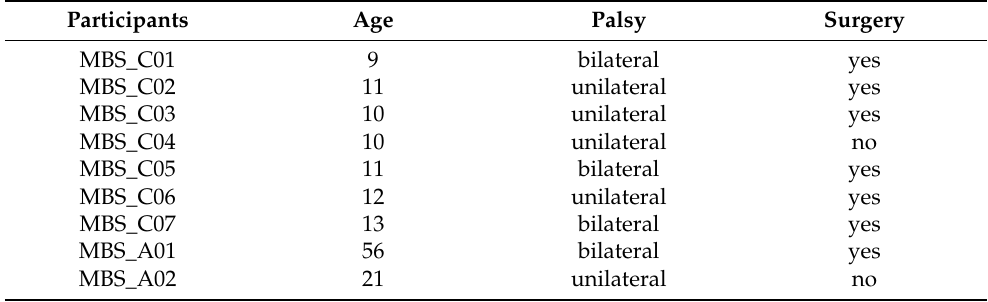
Table 1. Information about all the MBS participants involved in the study, including their age, their main clinical presentation (bilateral or unilateral palsy), and if they received a surgical procedure for increasing lower face mobility, which allows them to voluntarily produce a smile (see Section